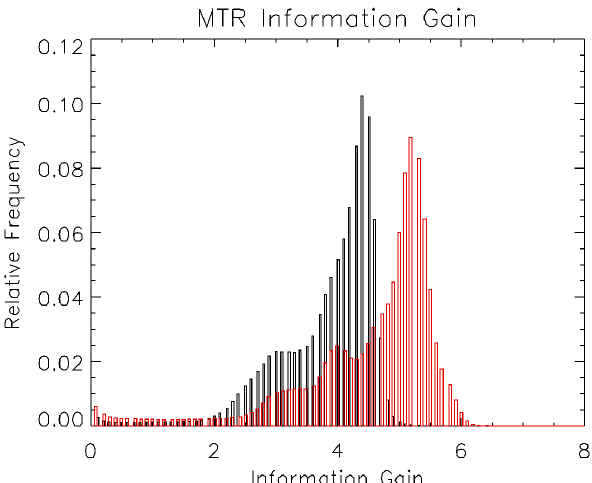
Fig. 5. Distribution of individual information gain values for temperature in the FR (black) and OR (red) GRD